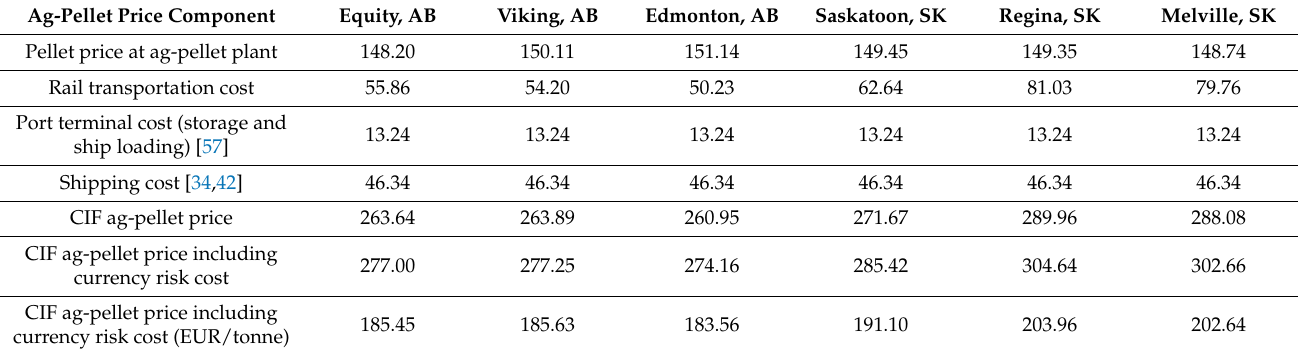
Table 5. Breakdown of average ag-pellet pellet price (CAD/tonne) from the six locations in Alberta and Saskatchewan to one of the three major ports in the